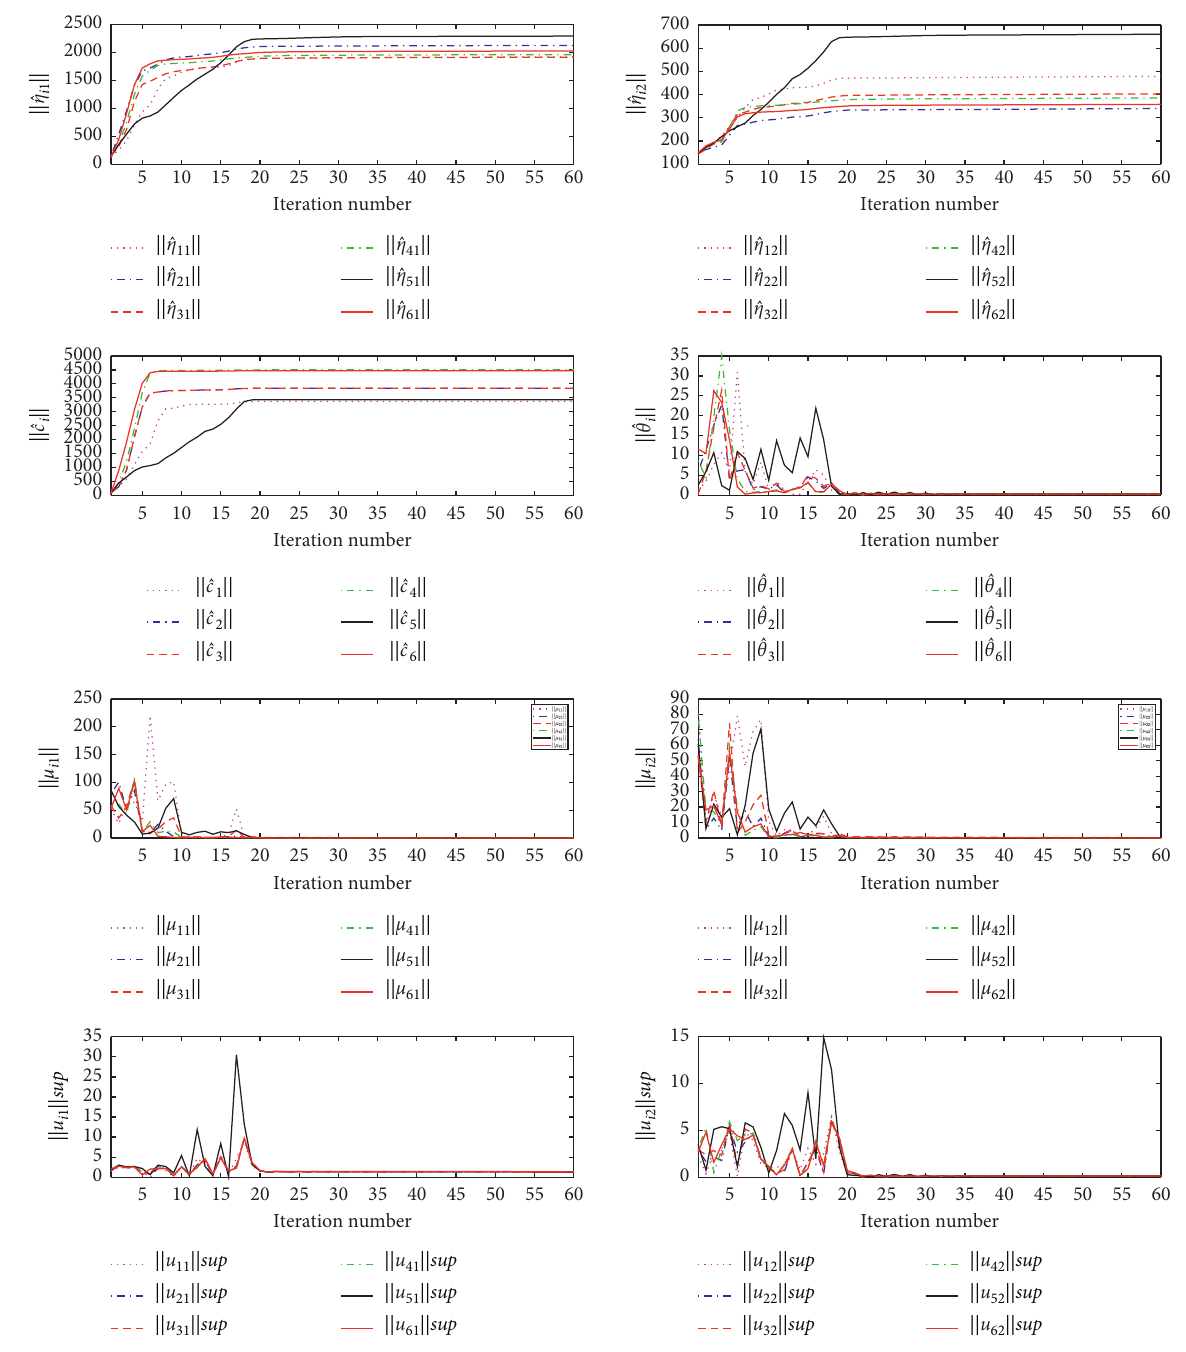
Figure 10: Responses of six follower